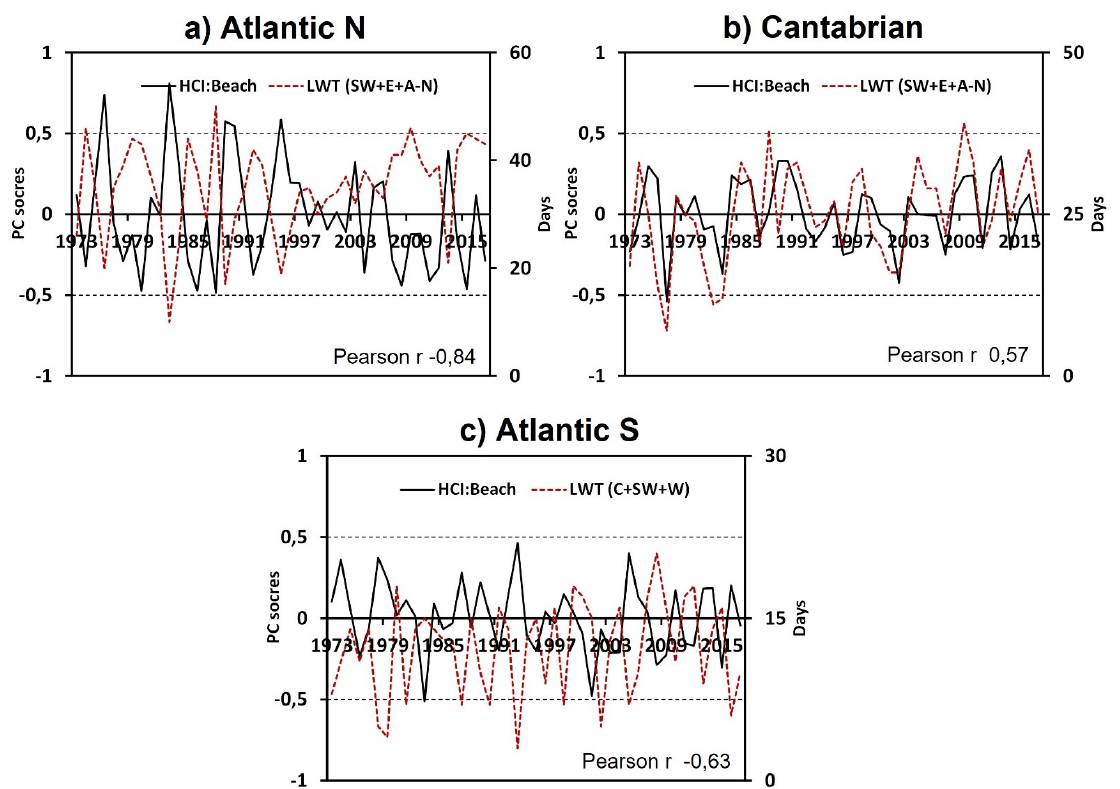
Figure 5. Normalized values of HCI: Beach index (thin line) and number of days corresponding to the most favorable LWT (dot line) for the ( a ) Atlantic N region ( b ) Cantabrian region ( c ) Atlantic S. The corresponding correlation coefficient is also presented.